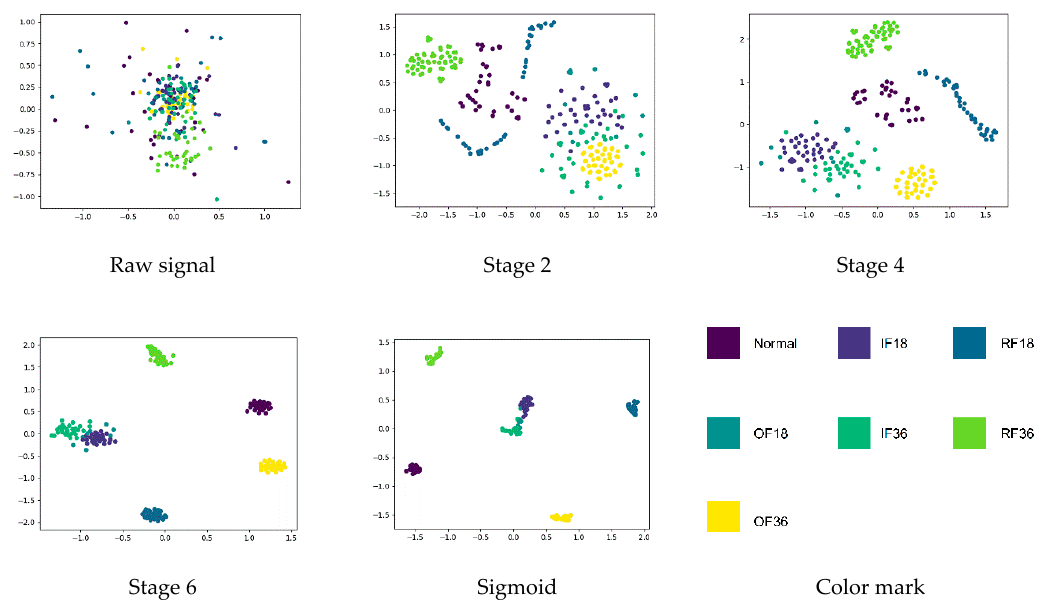
Figure 10. Learned feature visualization: feature representations extracted from raw signal, three stages, and sigmoid layer respectively.